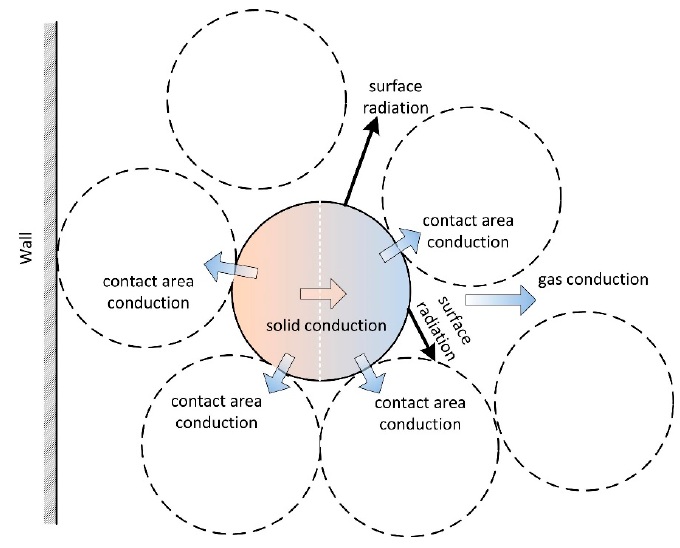
Figure 2. Heat transfer mechanisms in packed pebble bed.